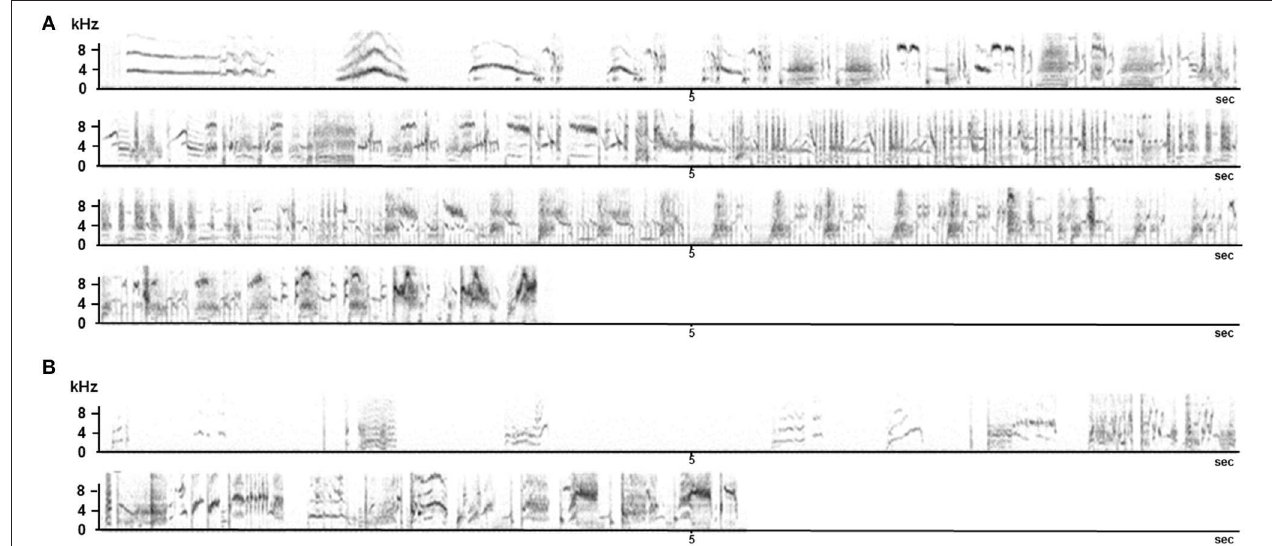
FIGURE 10 | Song sequences produced by an adult (A) and by a 2 year old birds that did not receive adult tutoring (B). Recordings were made at the same time of year.